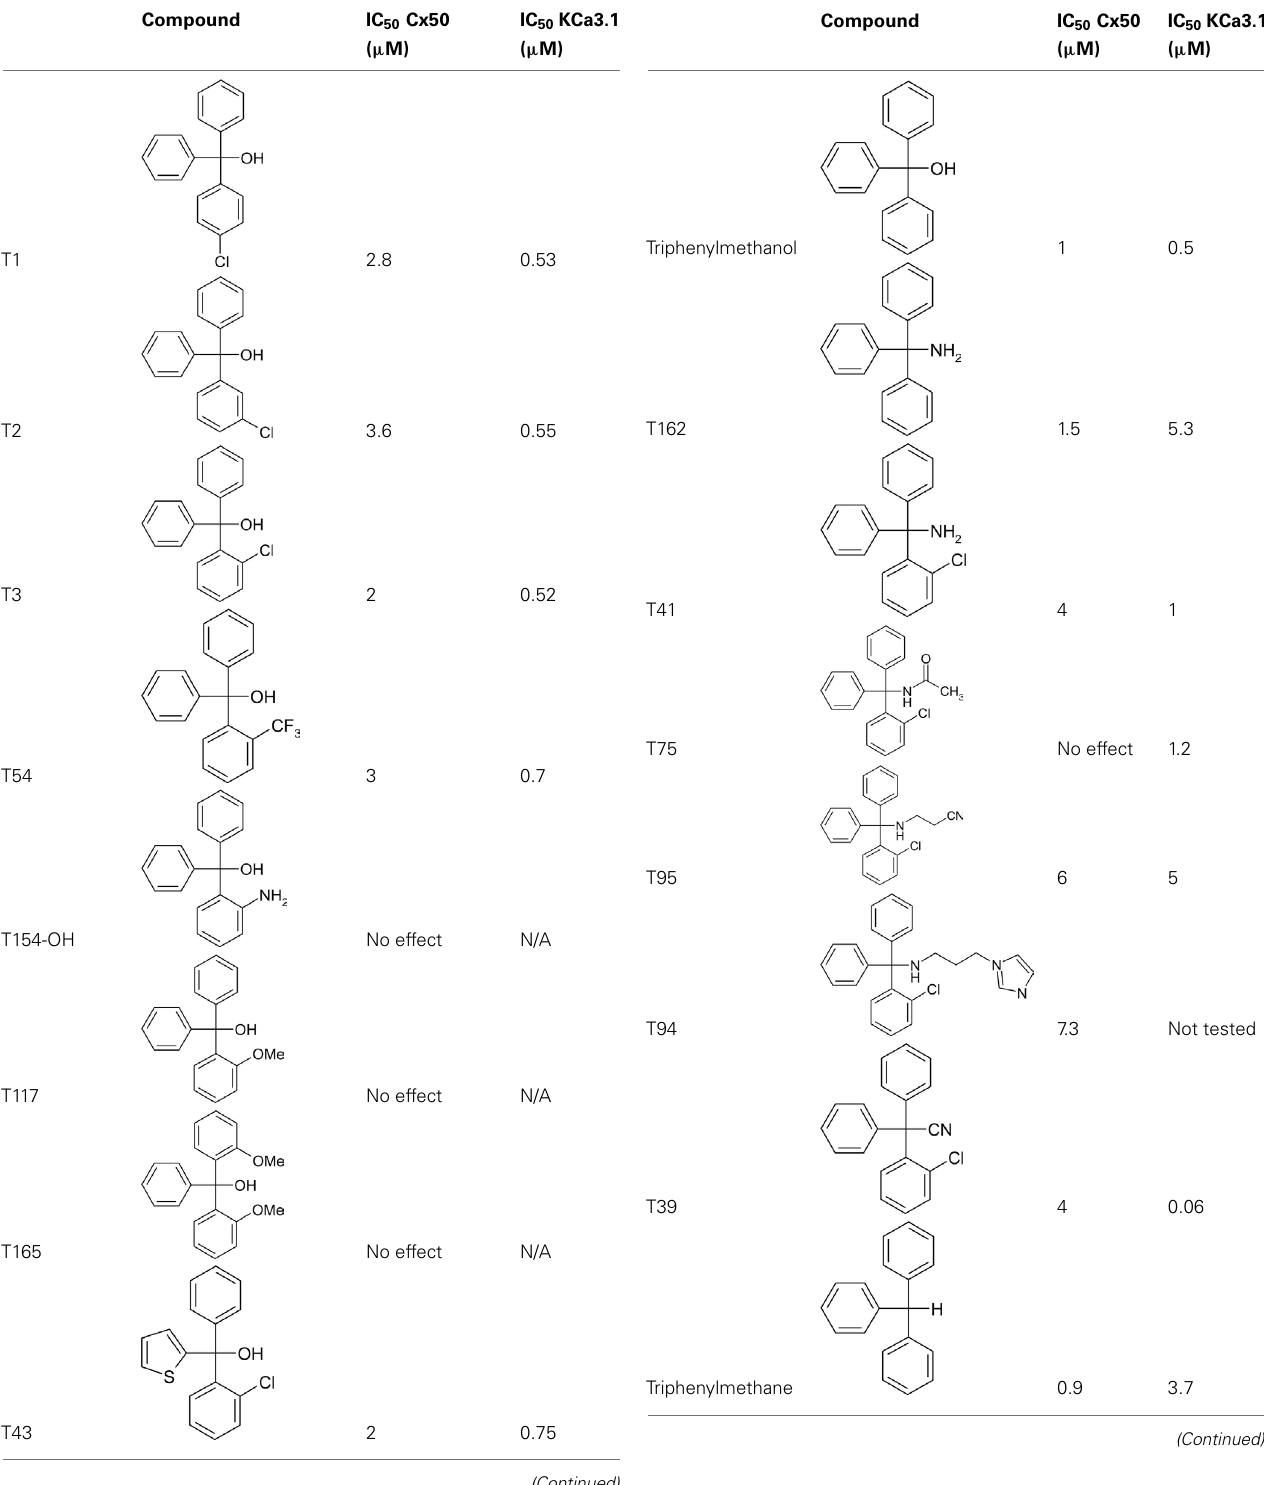
TableA1 | IC 50 values for Cx50 inhibition for triarymethane alcohols, amines, nitriles and